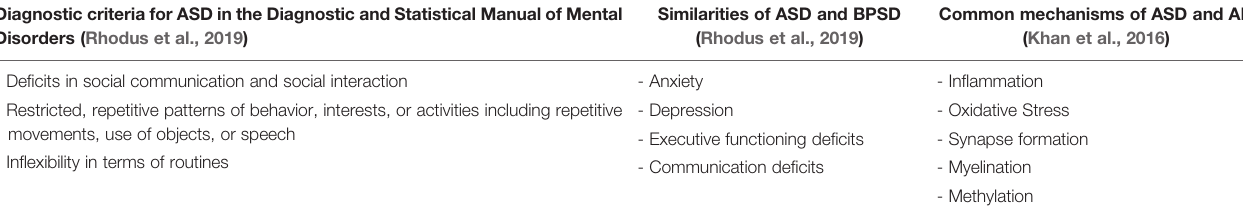
TABLE 1 | Relationship between ASD, BPSD and